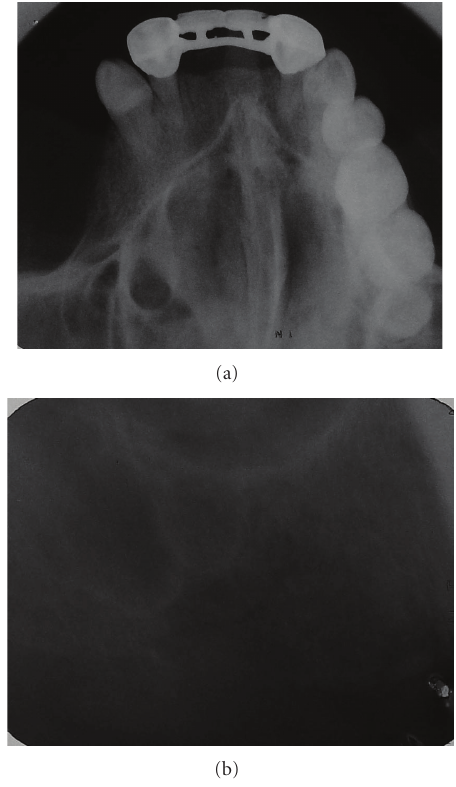
Figure 5: (a) Postoperative maxillary oclusal X-ray. (b) Postop- erative periapical X-ray. Notice the complete removal of the right maxillary foreign